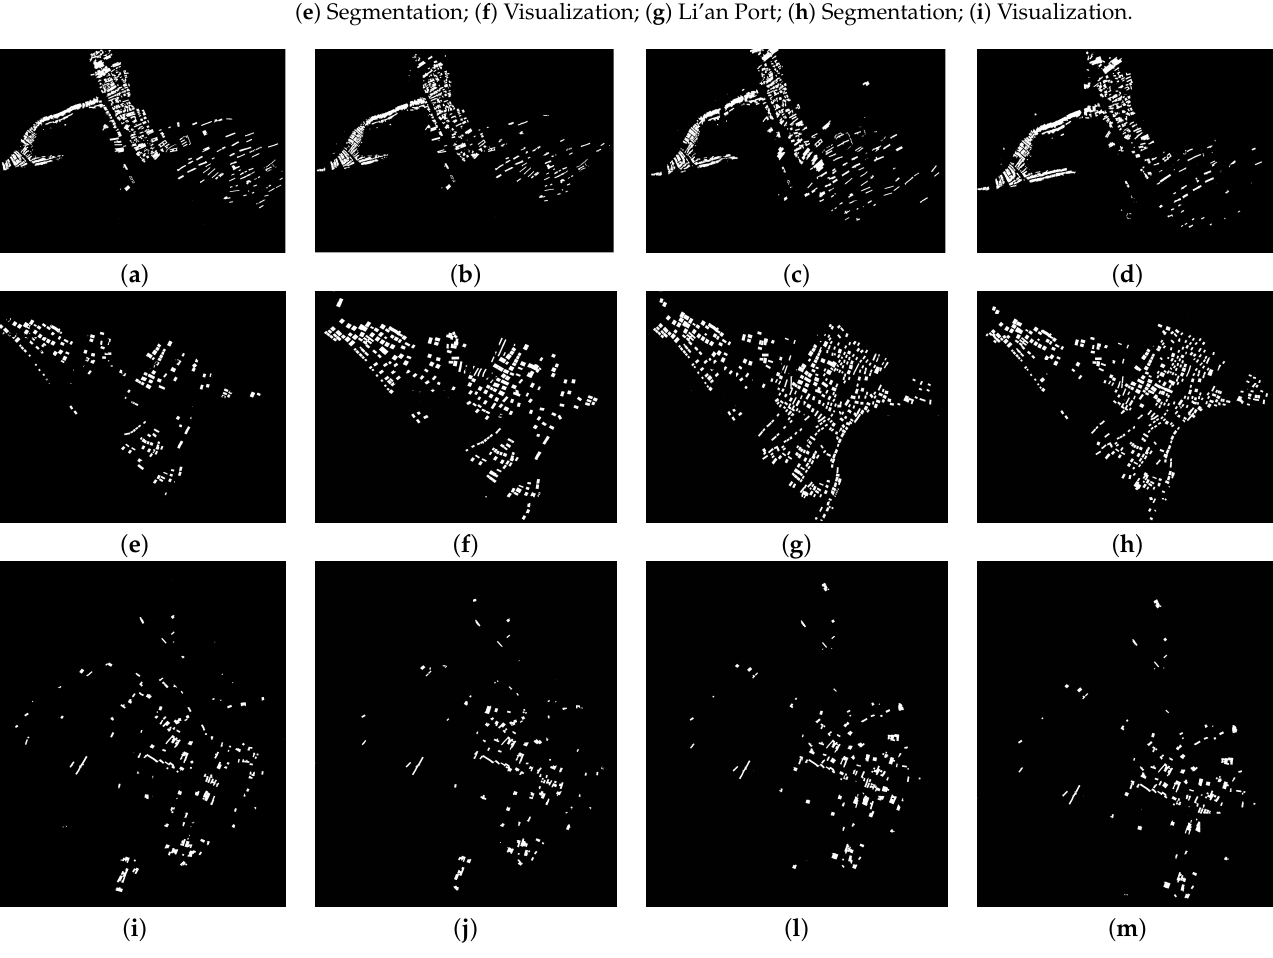
Figure 9. The results of test. ( a ) Potou Port; ( b ) Segmentation; ( c ) Visualization; ( d ) Xincun Port;